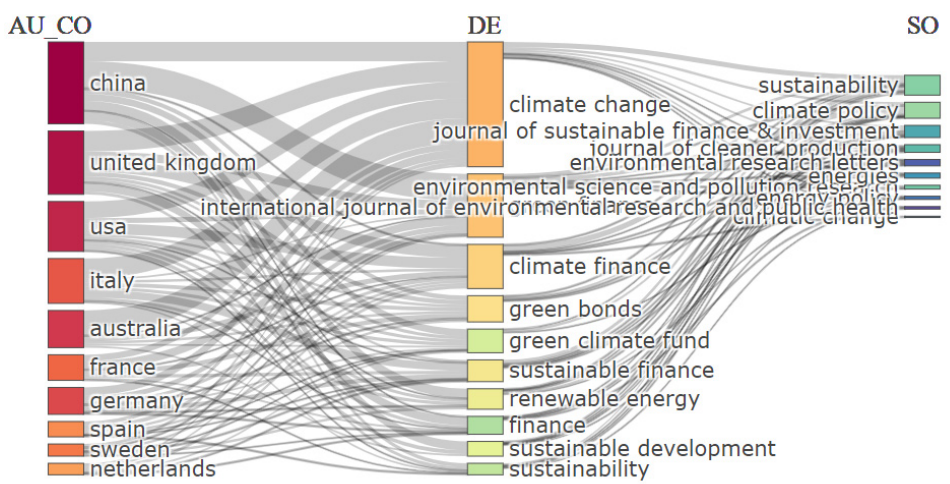
Figure 4. 3-field plot analysis on green financing. Source: Authors’ own compilation using bibliometric R-package.